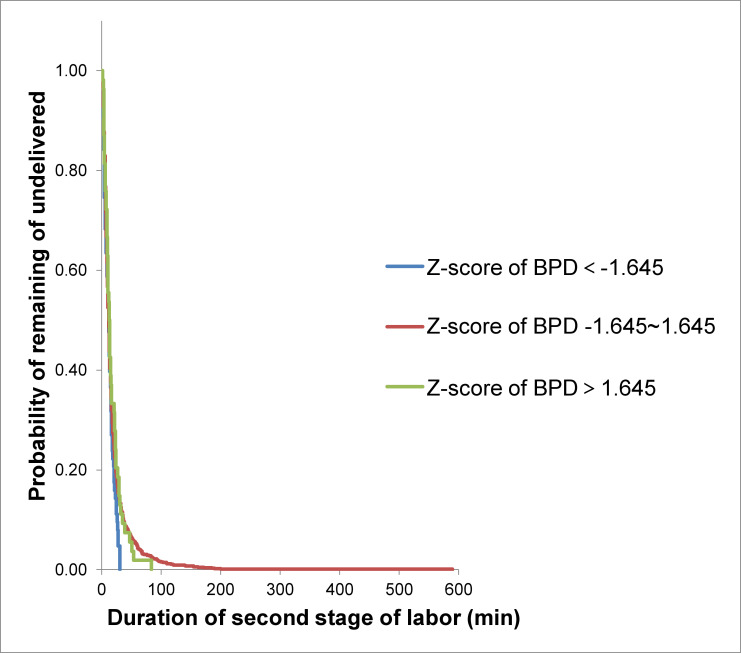
Kaplan-Meier analysis of the duration of second stage of labor according to Z-score of BPD in multiparous women.